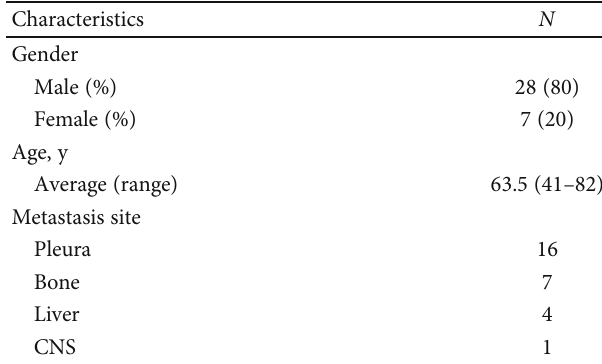
Table 1: Characteristics of the study samples.